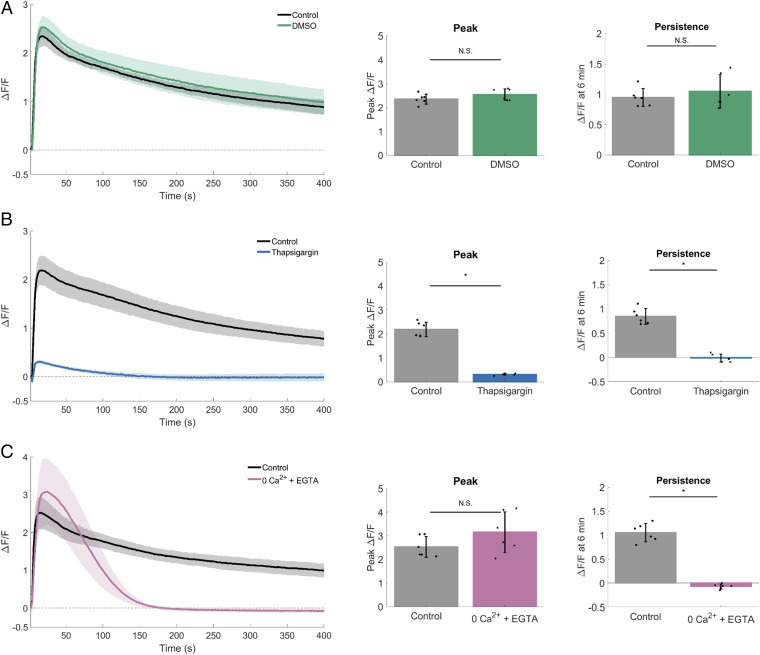
Intracellular and extracellular calcium stores are necessary for mechanically stimulated calcium signaling. For each dataset, traces show mechanically stimulated calcium signaling (ΔF/F) plotted over time for control and treated cells. Bar graphs show quantification of peak ΔF/F and ΔF/F at 6 min (persistence). (A) Quantification (peak ΔF/F and ΔF/F at 6 min) revealed rapid mechanically stimulated increases in intracellular calcium that persist for longer periods of time. DMSO had no effect on calcium signaling. (B) Compared with control, peak ΔF/F and ΔF/F at 6 min was blocked in groups depleted of intracellular calcium (2 µM thapsigargin). (C) Depletion of external calcium (0Ca2+ + EGTA) did not significantly change peak ΔF/F but blocked ΔF/F at 6 min. Data are presented as mean ± SD. The asterisk (*) indicates significance from control, P < 0.05 via paired t test. N.S. indicates no significant difference. Data represent n = 6 in total from six independent experiments for each group. Control groups were collected separately for each dataset.